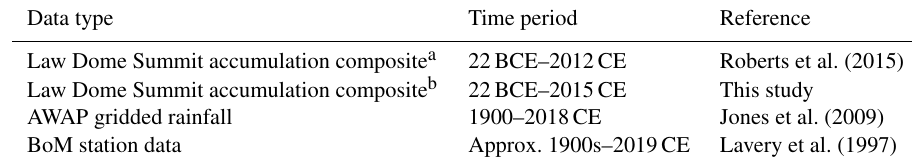
Table 1. Observational data types include two DSS snow accumulation records, AWAP gridded rainfall and BoM station data.